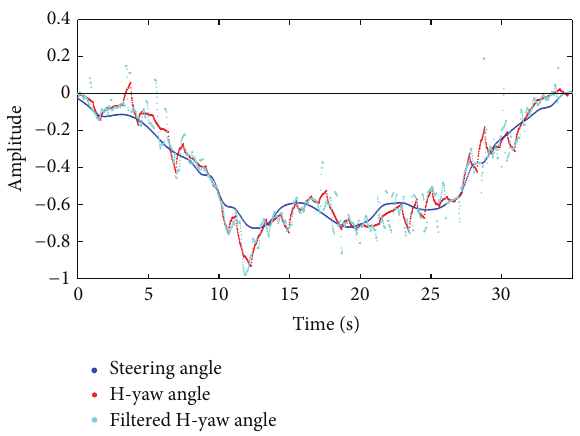
Figure 8: Gaze direction in the earth-fixed coordinates. direction and the vehicle’s true heading, that is, agreement of gaze direction and steering